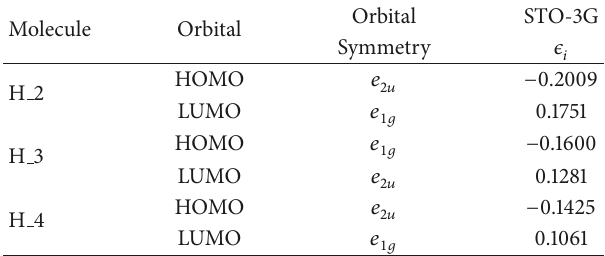
Table 3: Orbital energies ( 𝜖 𝑖 ) and occupancies ( 𝑛 𝑖 ) at RHF level for H n .